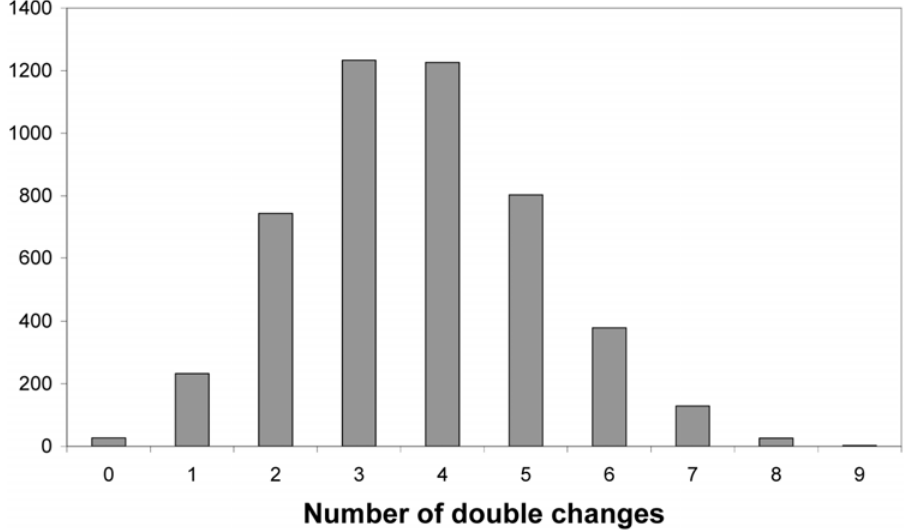
Figure 2. Number of double changes and the number of pathways. For each number of double changes, the number of accessible pathways with that number of double changes (allowing back mutations) is given.